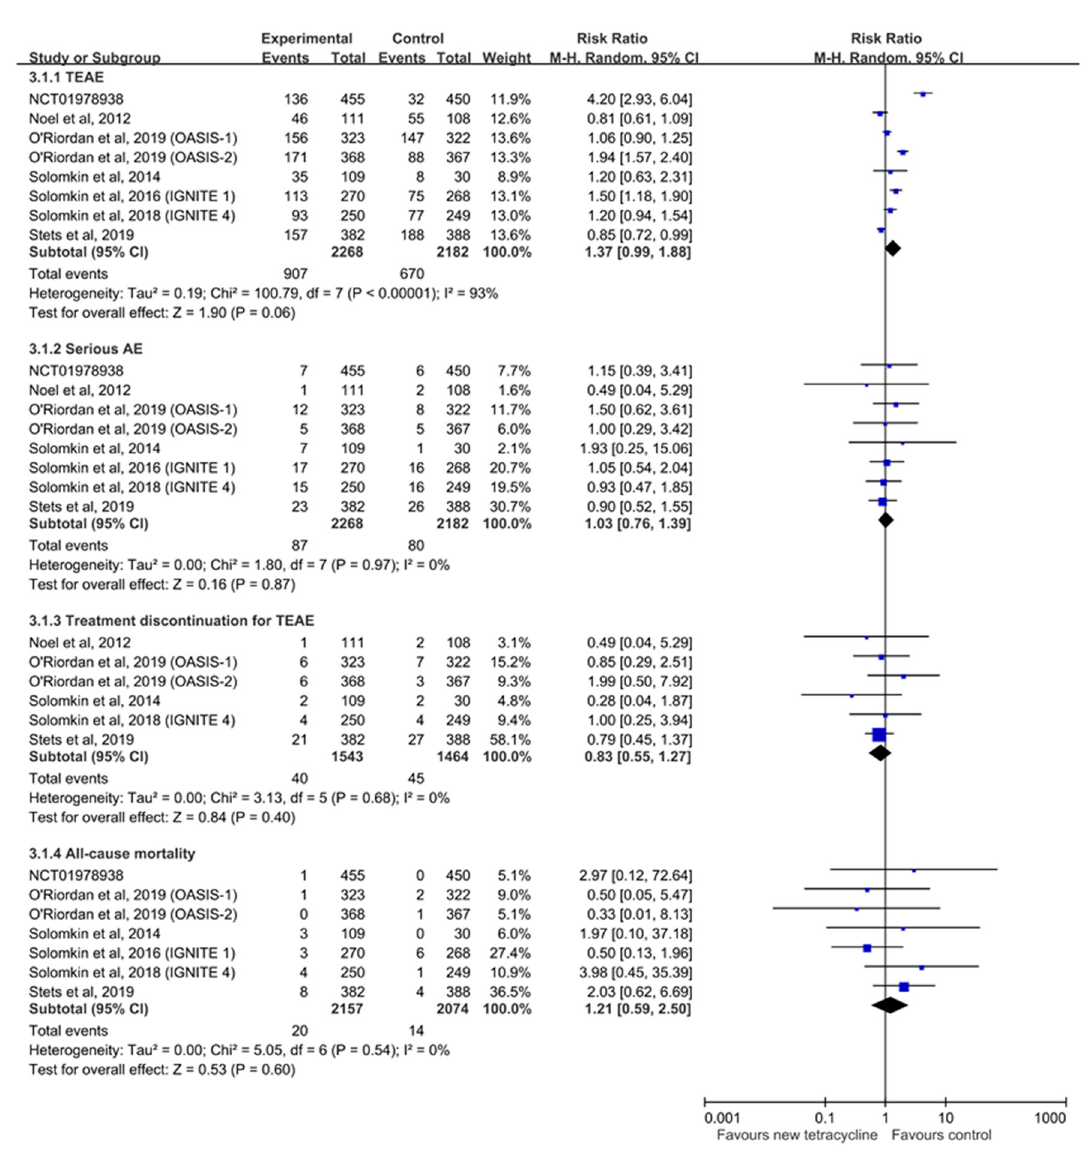
Figure 5. Forest plot of risks of treatment-emergent adverse events (TEAEs), serious adverse events, and discontinuation of treatment due to TEAE and all-cause mortality.